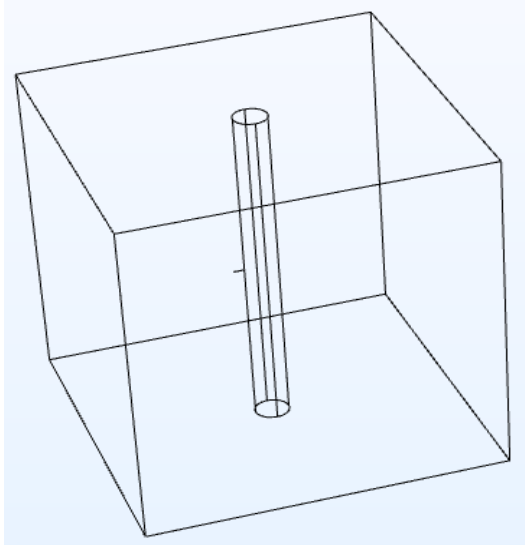
Figure 4. Numerical model constructed by intercepting part of the shaft and surrounding rock.